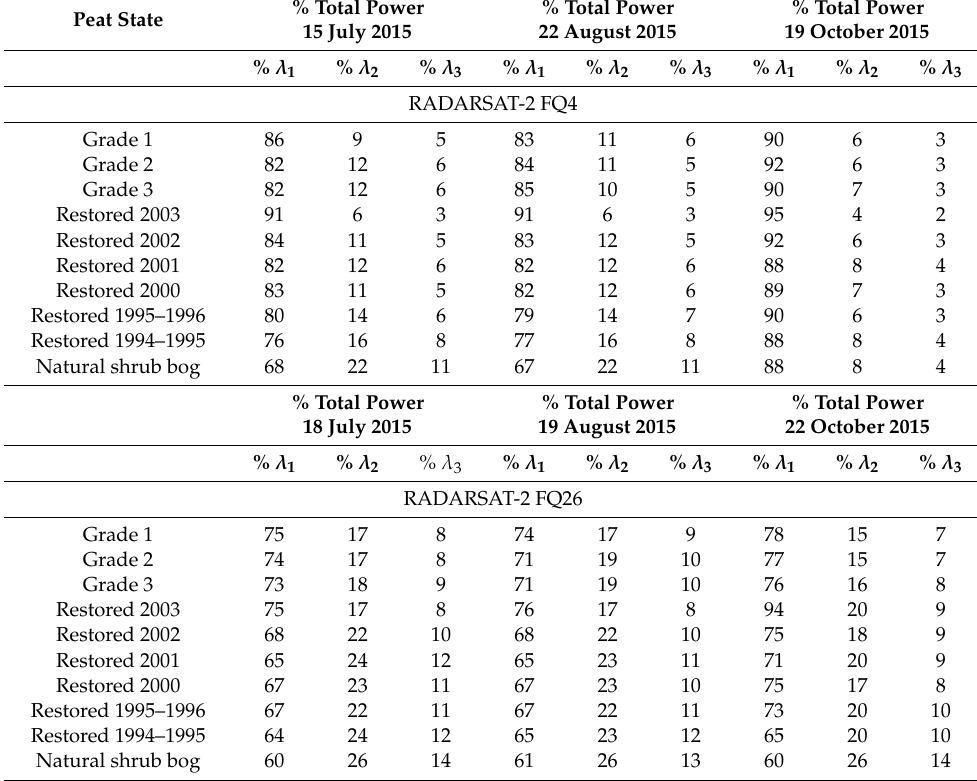
Table 6. Total power contributions from the three types of scattering mechanisms in the Touzi incoherent target decomposition (ICTD). λ 1 is representative of the percentage of total power from rough surface backscattering, λ 2 from double-bounce backscattering, and λ 3 from volume